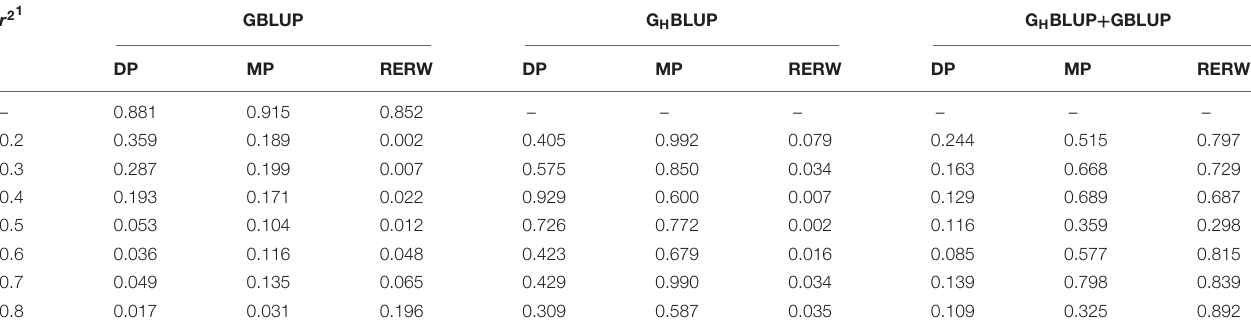
TABLE 6 | P -values of Hotelling’s t -test comparing the prediction accuracy obtained with the 770K data and the WGS data. r 21 GBLUP G H